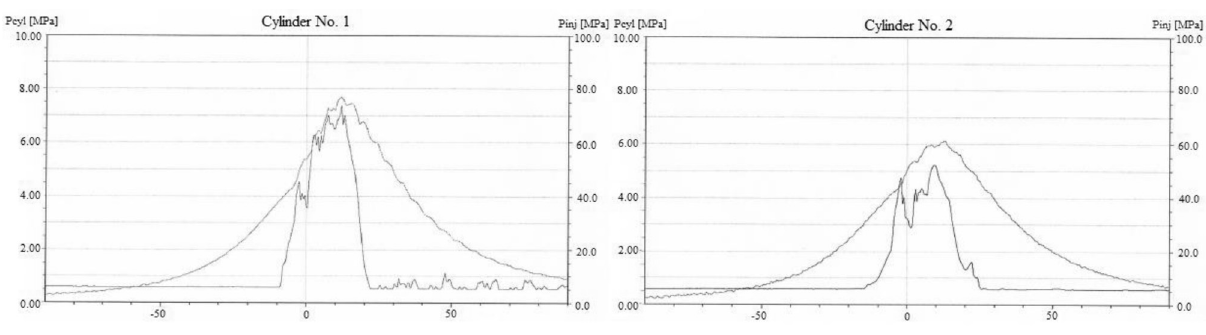
Fig. 4. The example diagram of combustion pressure and the injection pressure for P = 180